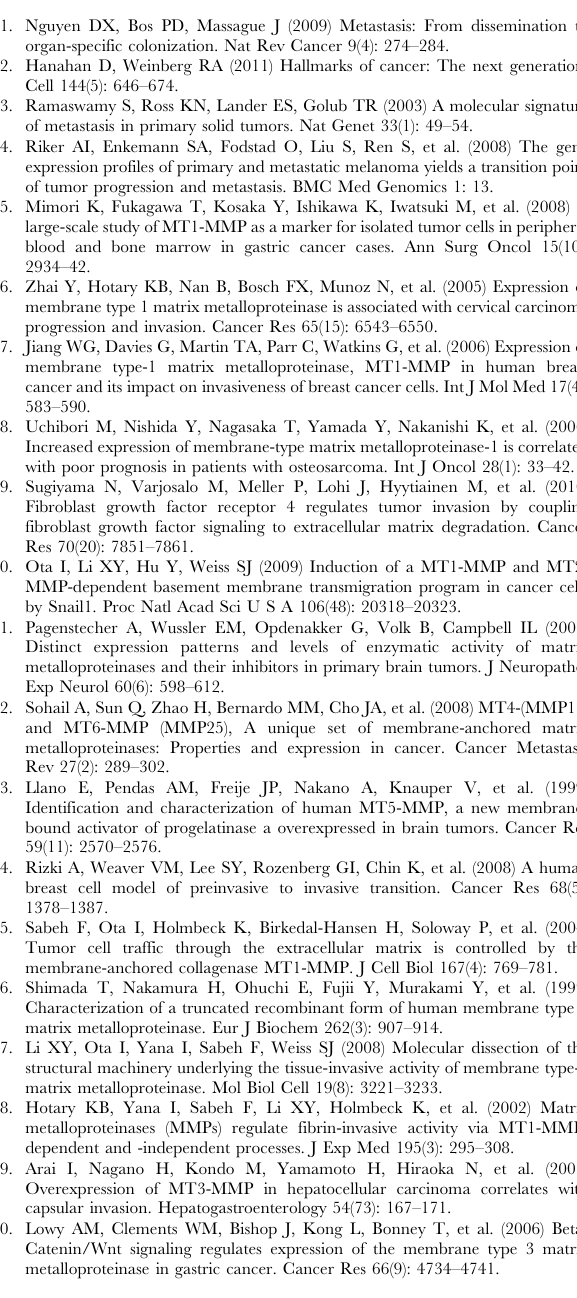
3D fibrin and type I collagen for 5 d. Quantitative results are expressed as the number of invasive foci per microscopic field (n =3). (C) Light micrographs of fibrin and collagen cross-sections visualize the invasion of Bowes cells transfected with the indicated siRNAs. White dotted lines mark the surface of the matrix. (D) Cells transfected with the indicated siRNAs were embedded in 3D collagen type I gels as single cell suspension. Light micrographs show the cells after 5-d assay (n= 3).